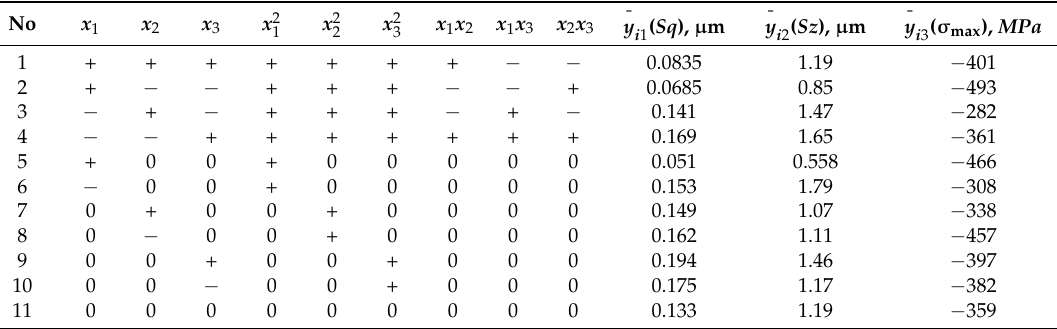
Table 2. Matrix of research